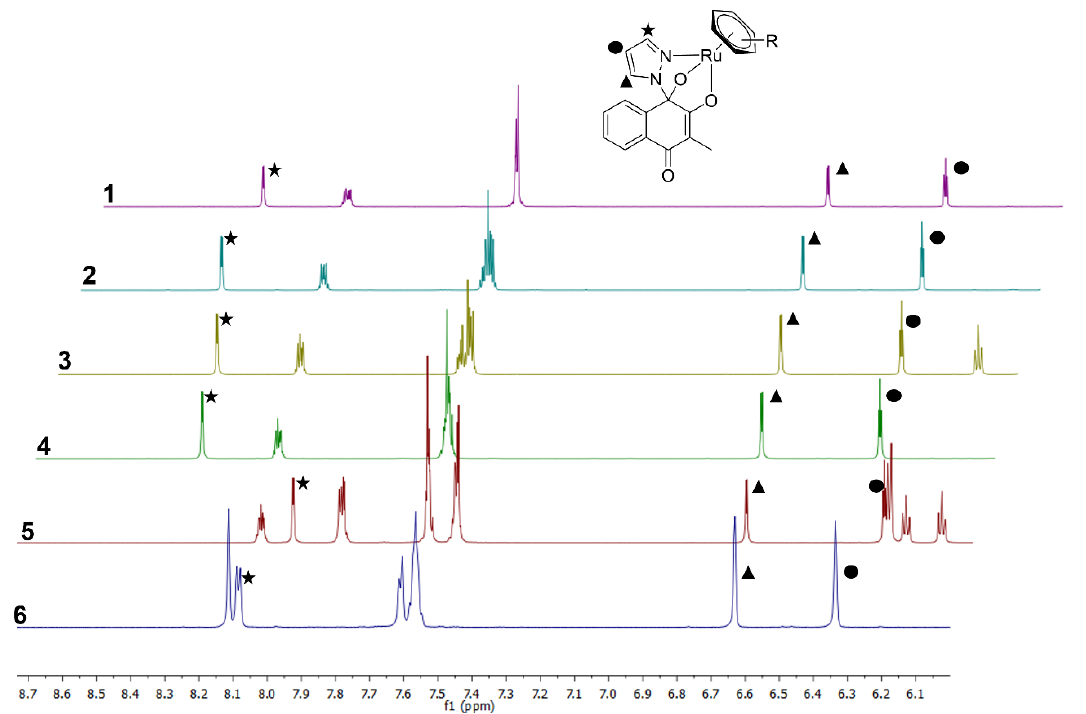
Figure 3. Arene influence towards the chemical shifts of pyrazolate in MeOD-d 4 . R = p -cymene = 1 , R = benzene = 2 , R = toluene = 3 , R = indane = 4 , R = biphenyl = 5 , R = hexamethylbenzene = 6 .